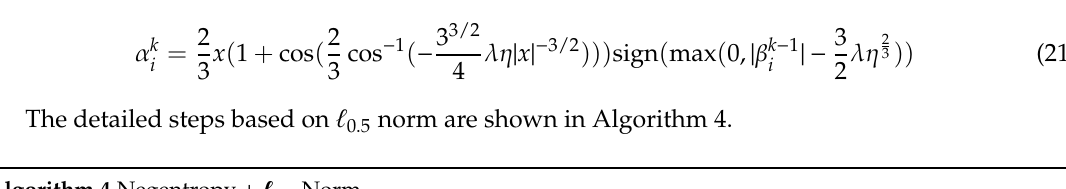
Algorithm 4 Negentropy + (cid:96) 0.5